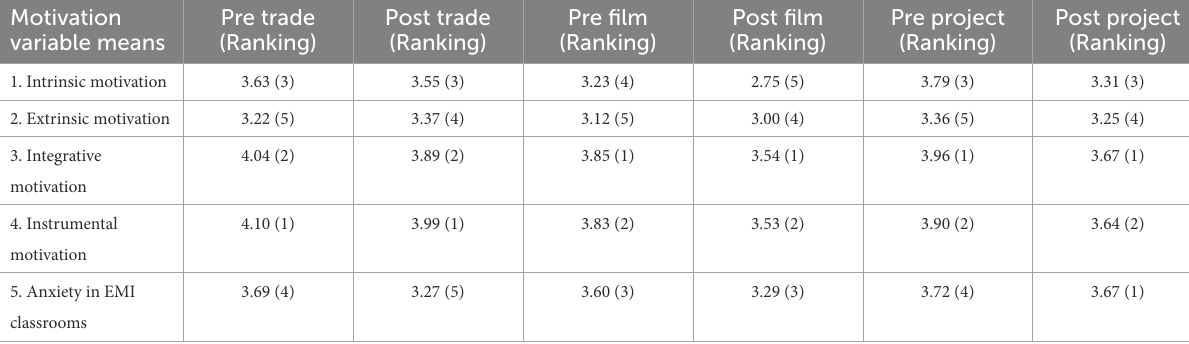
TABLE 2 Pre-post student questionnaires (motivation variable